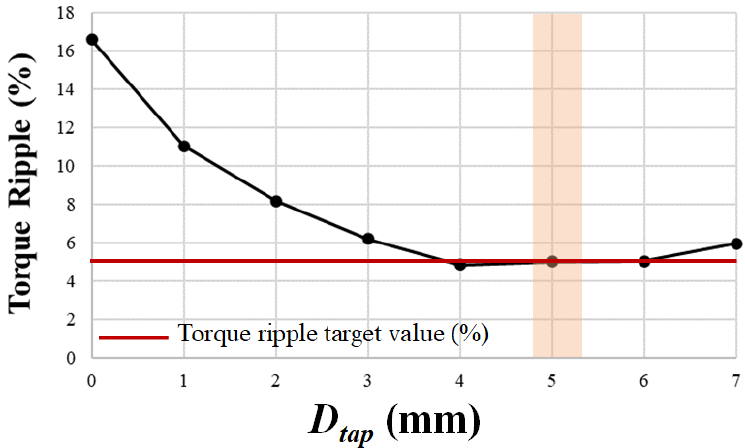
Figure 17. Torque ripple with D tap (4000 rpm). Table 3. Specification of the final model with